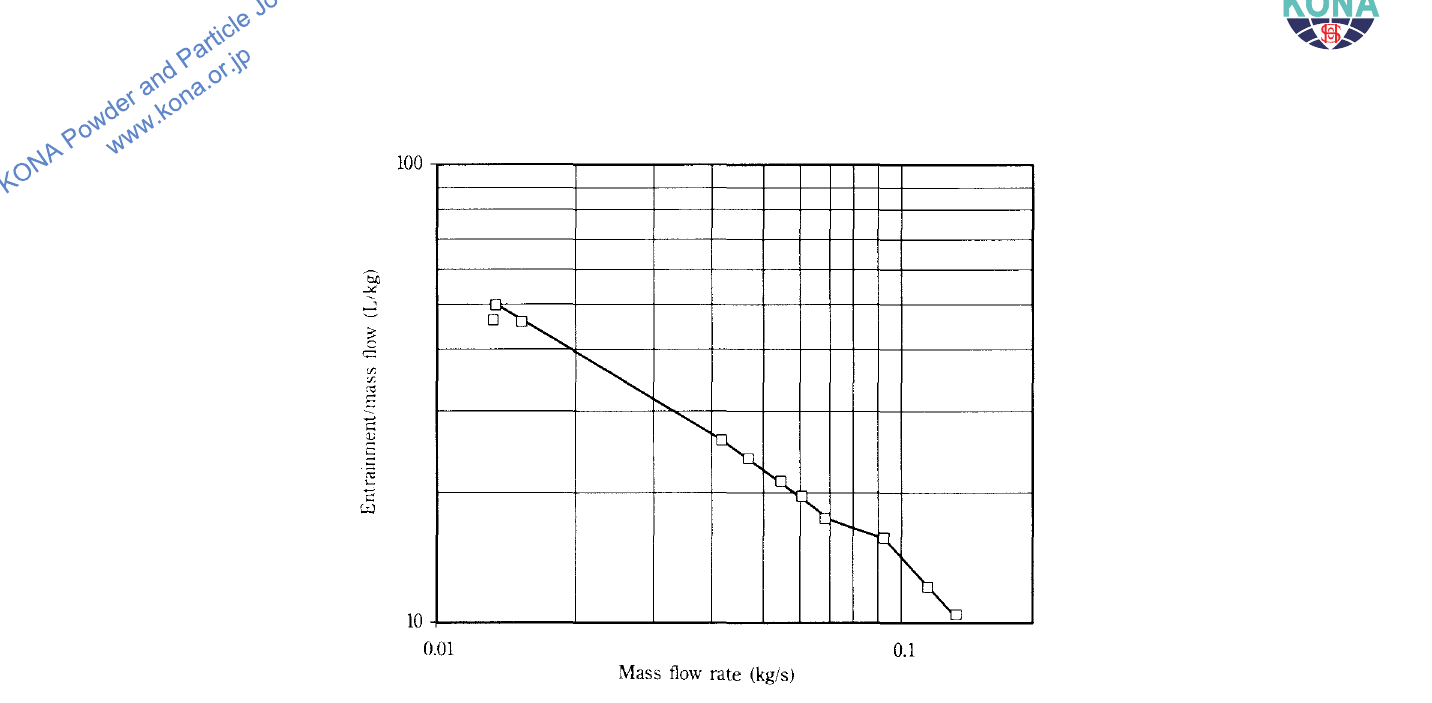
Fig. 9. Air entrainment normalised with respect to parent material flow rate for constant drop height, z =